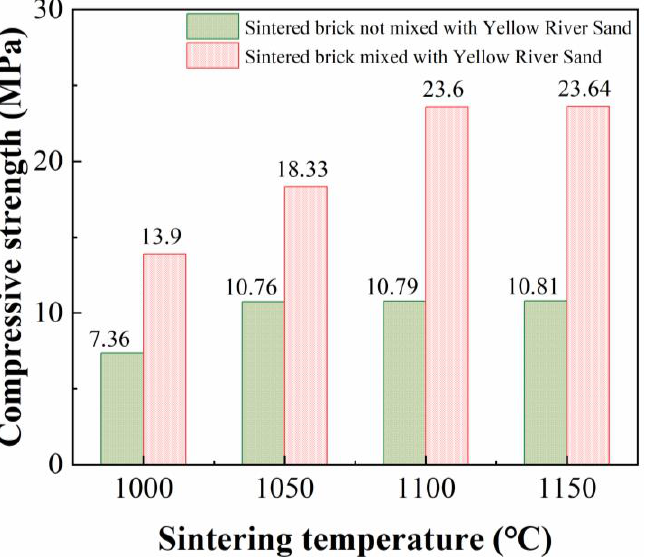
Figure 6. Effect of sintering temperature on compressive strength of MGS sintered